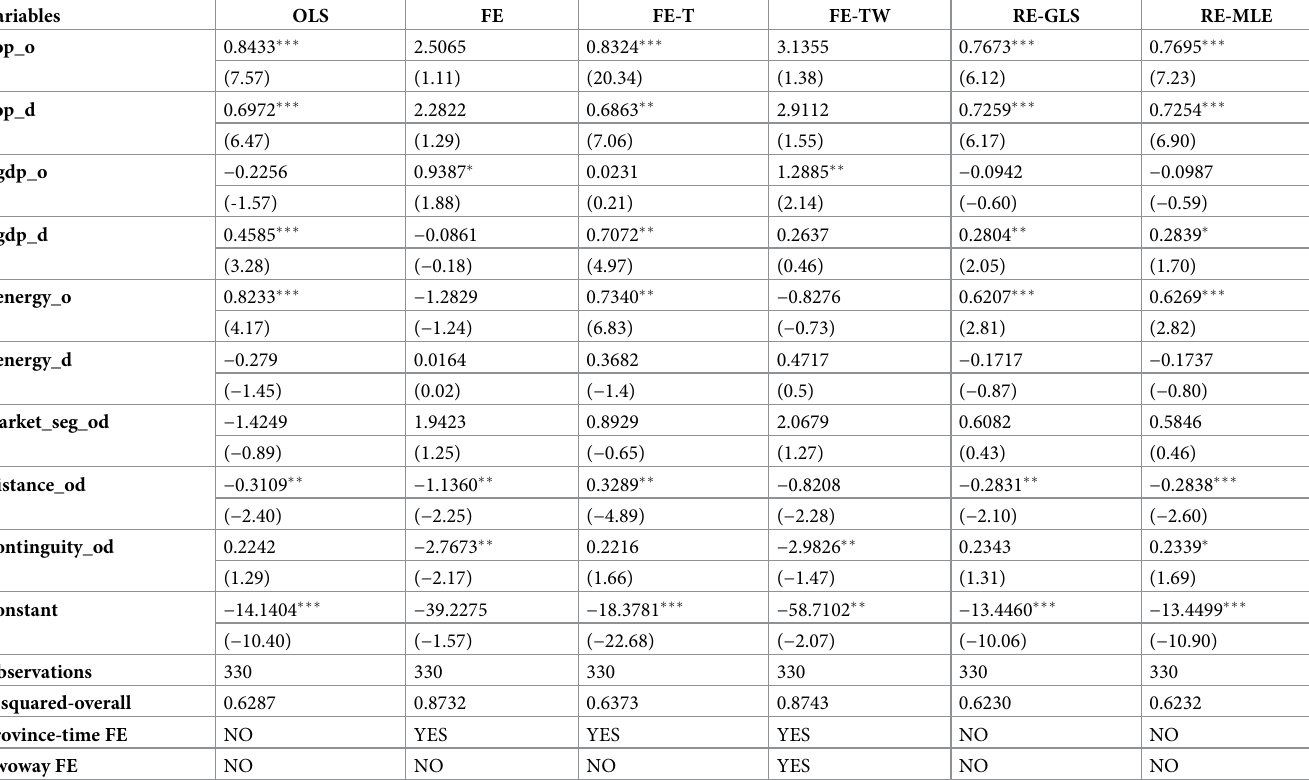
Table 4. The gravity estimated results using interprovincial embodied CO 2 flows within Western China.